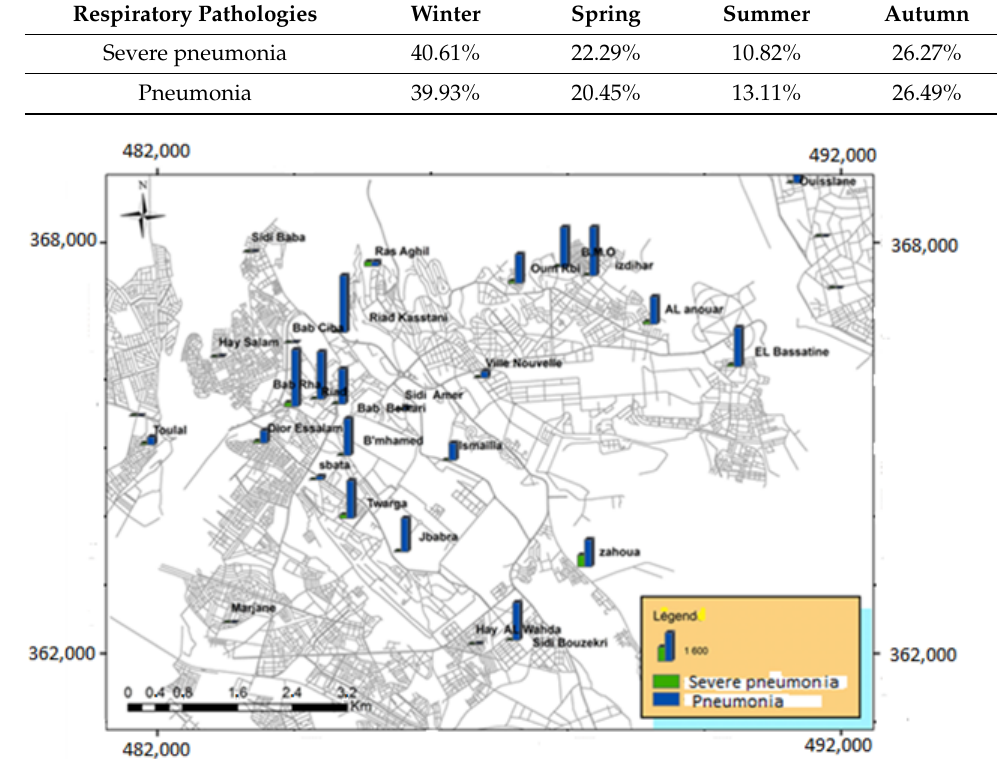
Table 6. Seasonal distribution of respiratory diseases in children under five years of age.